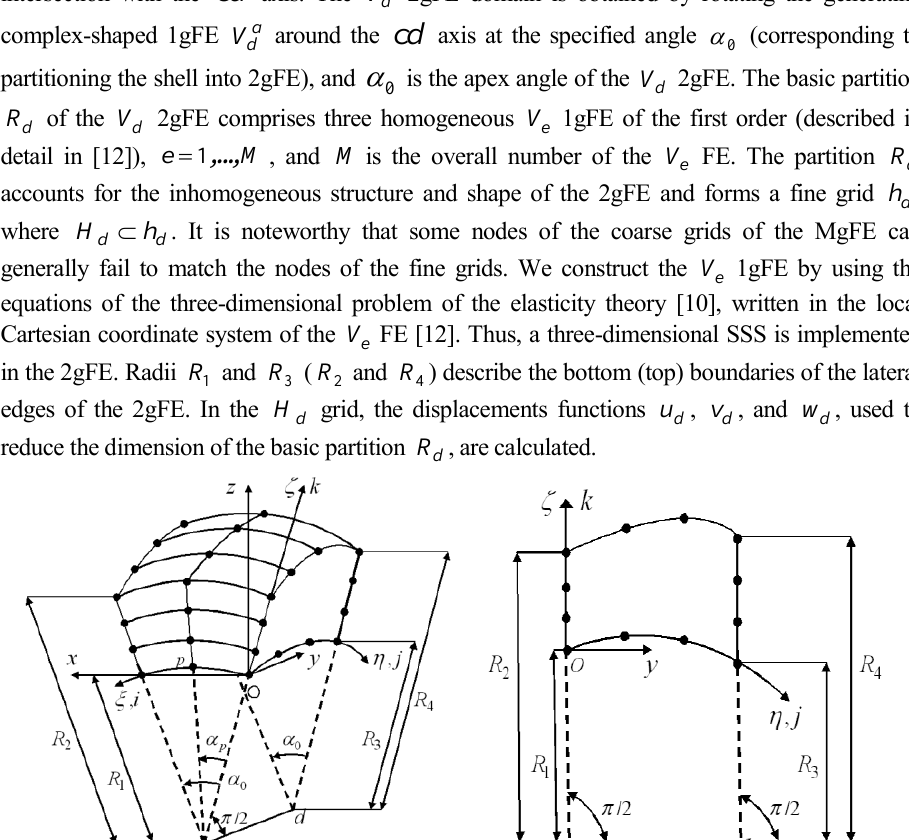
V . Fig. 2. Generating 1gFE a d